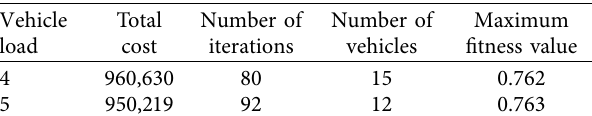
Figure 4: Returned routes from front warehouses to customers. Table 4: Comparison of types of vehicles used in new retail net- work